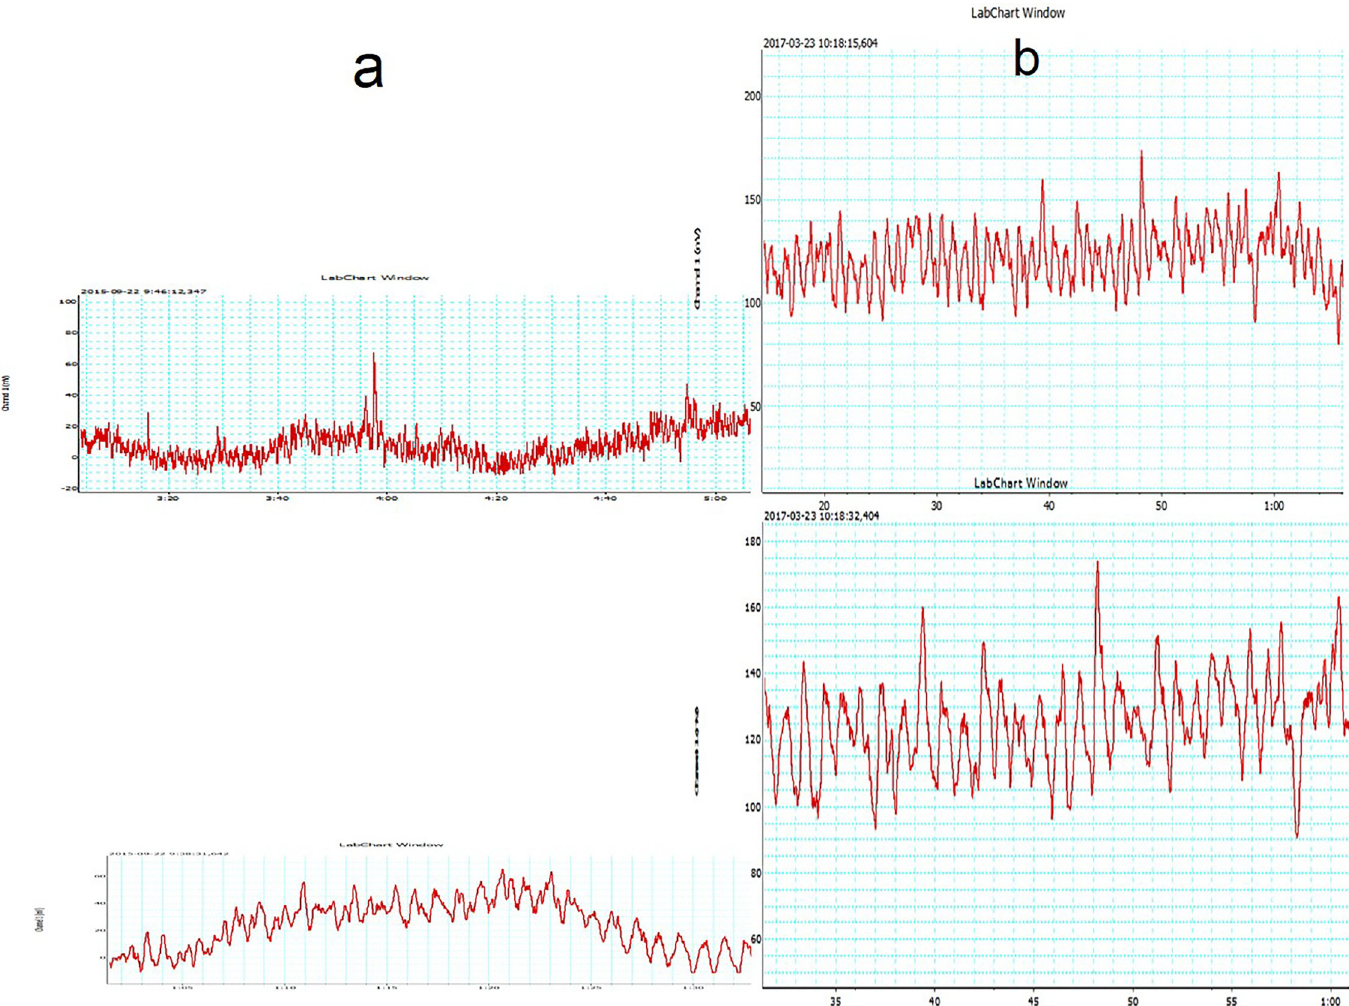
Fig 9. Laser Doppler recording of the big toe capillary flow velocity (in millivolts) in two patients with multifocal calf arteries occlusions after 2 years of the applied arterial assist. a-before and b- after long-term support. pre- and post-IPC scales adjusted. Evidently higher amplitudes after long-term